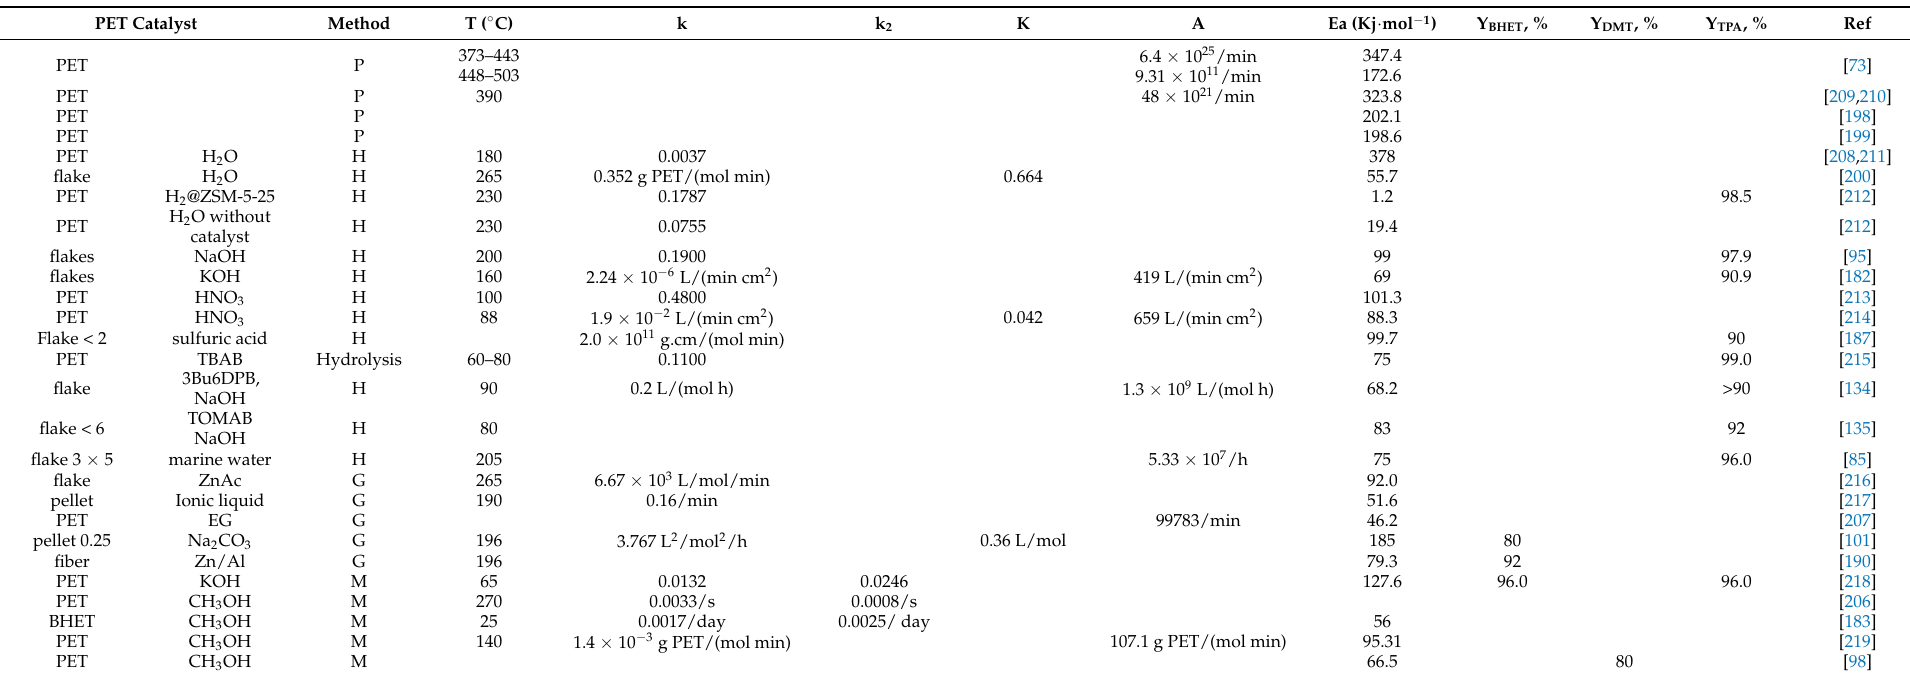
Table 4. Kinetic and modeling analysis of PET with different types of condition